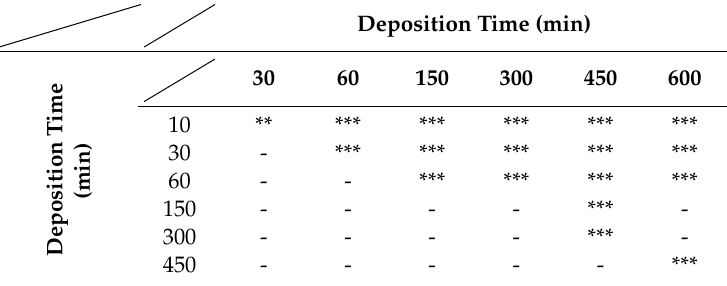
Figure 2. Results of the analysis of the SEM images showing ( a ). The average pore area of each modified PEEK sample; ( b ). The average Ferret’s diameter of each modified PEEK sample; ( c ). The average number of pores for each modified PEEK samples. Table 2. Statistical analysis of the average pore area of each across a variety of modified PEEK surfaces.